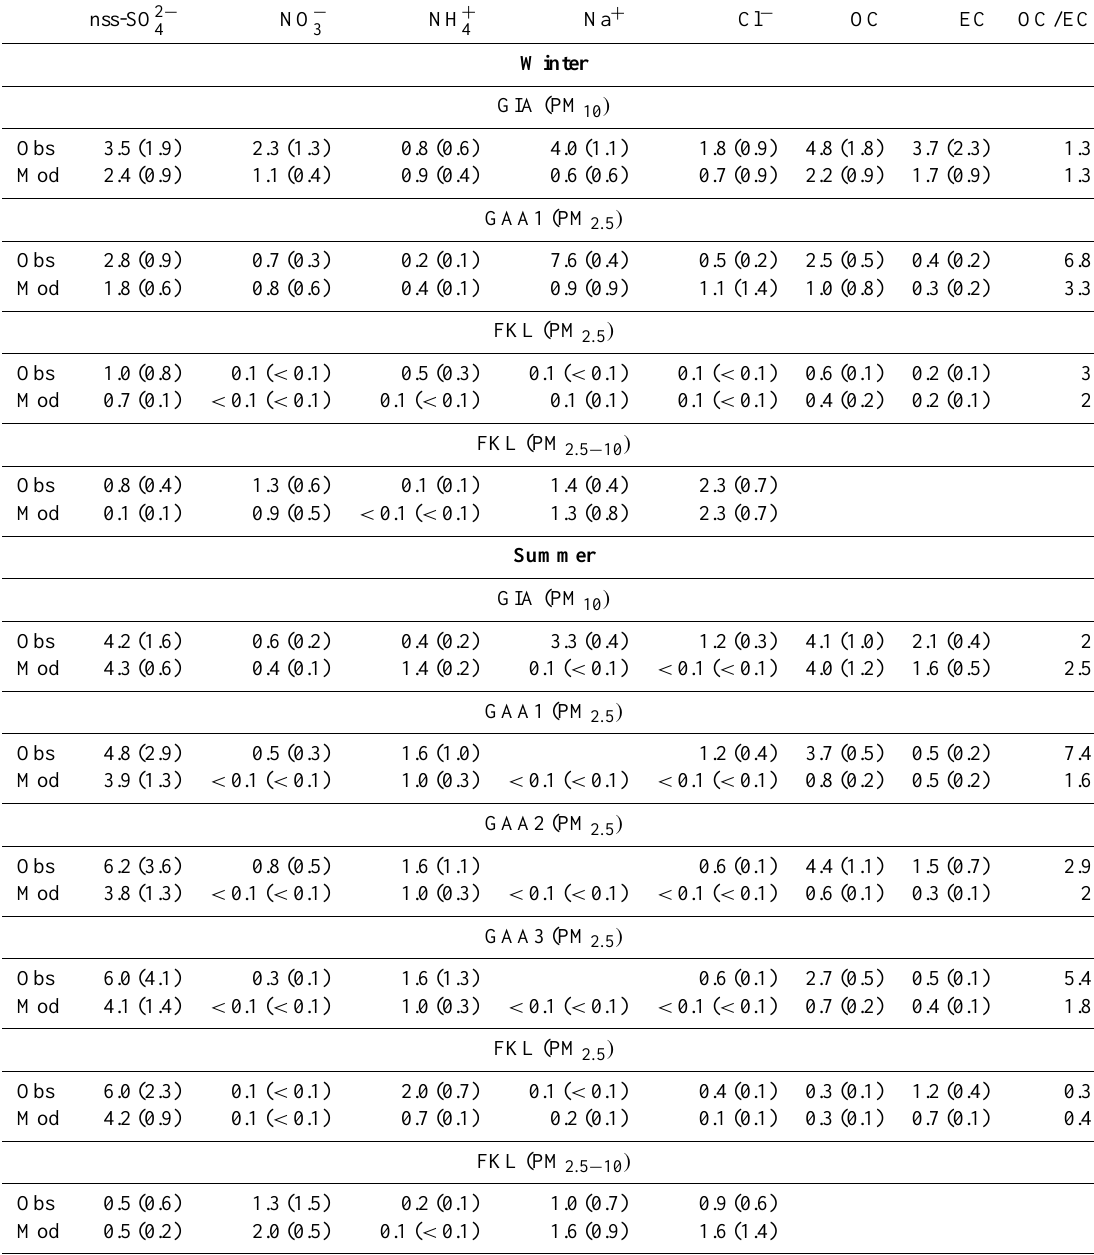
Table 3. Simulated (Mod) vs. observed (Obs) aerosol species over GIA, GAA and FKL, averaged over the simulation periods of winter (December) and summer (July) 2008. Standard deviation is given in parenthesis and units are µgm − 3 . The stations used in the comparisons are Bogazici University (ESC) in GIA (Theodosi et al. (2010) for December and July 2008), Penteli in GAA1 (Paraskevopoulou et al. (2012) for December 2008 and Pateraki et al. (2012) for July 2008) and Geoponiki in GAA2 (Pateraki et al. (2012) for July 2008), Aegina in GAA3 (Pateraki et al., 2012 for July 2008) and FKL (Mihalopoulos, unpublished data for July 2008 and December 2008). nss-SO 2 − NO − NH + 4 3